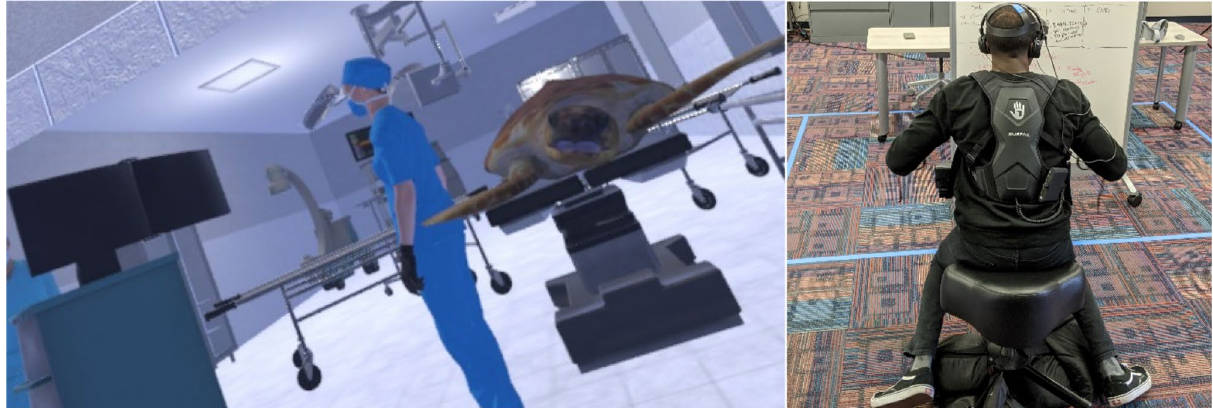
Figure 3. View from the participant’s perspective during animal embodiment. Participants sit on a custom- built seating apparatus allowing for a non-bipedal posture. A SUB-PAC delivers synchronous haptic feedback to the user’s spine, functioning as their carapace in the simulation (right). Users begin the simulation in a virtual sea turtle hospital. Participants in the visuomotor representation condition see, via a virtual mirror, their head and hand movements synchronously reflected onto their sea turtle avatar